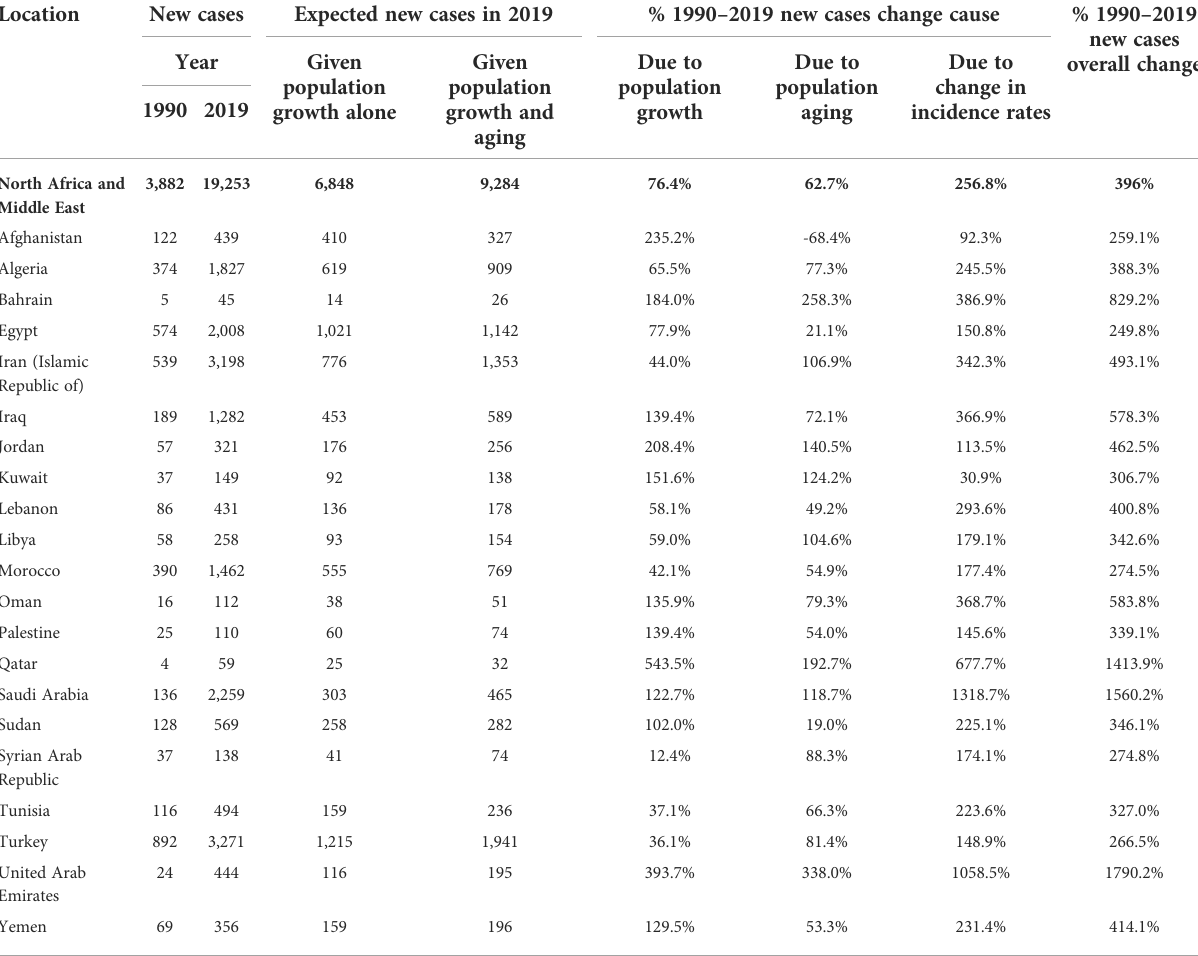
The bold values in this table illustrate the regional